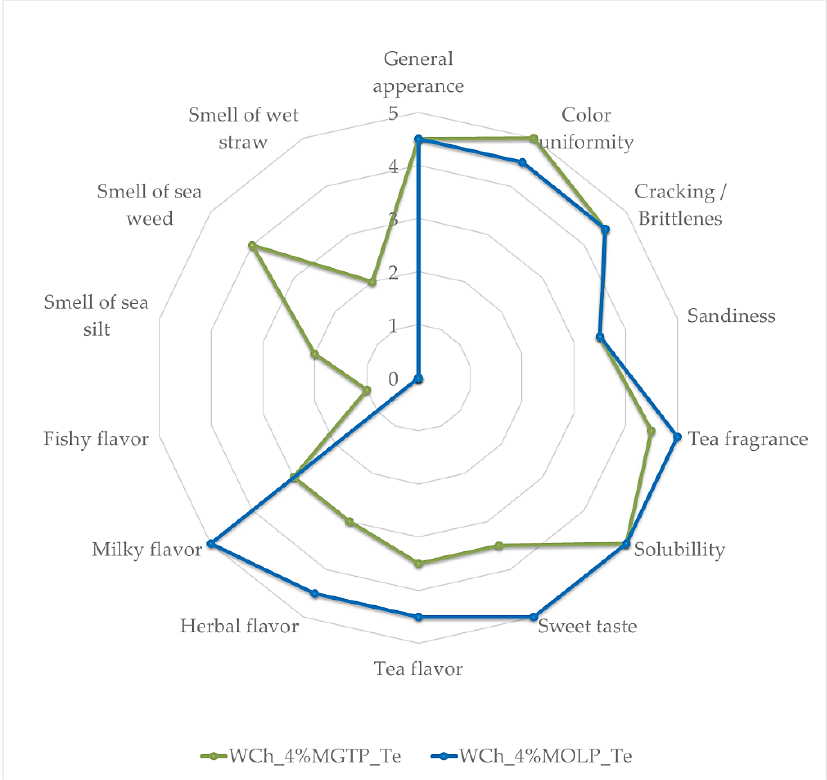
Figure 2. Average sensory ratings of individual attributes of white chocolates with 4% addition of matcha green tea powder and moringa leaf powder introduced during tempering process.